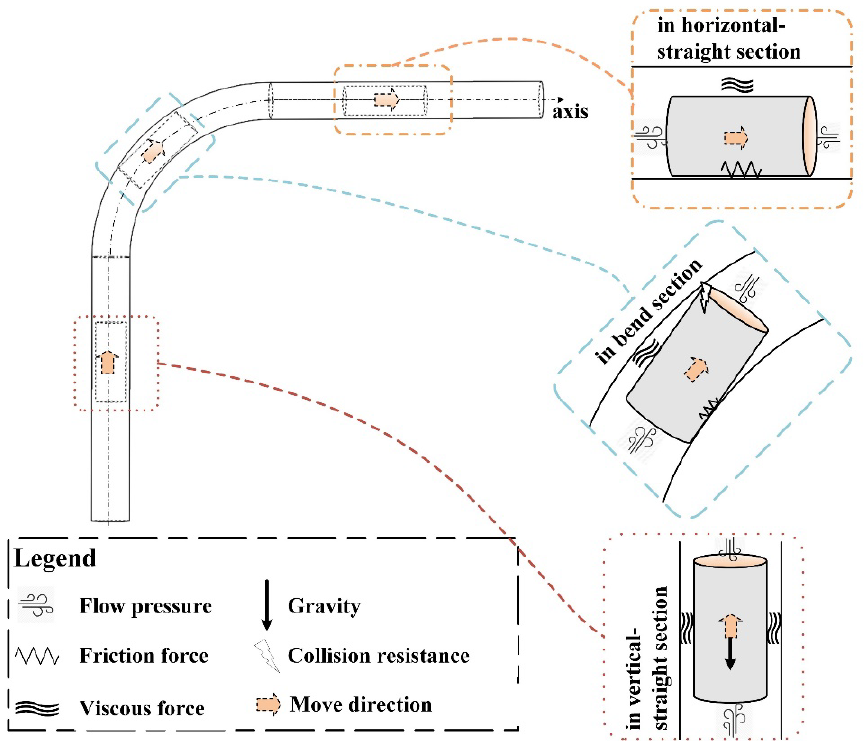
Figure 1. Schematic diagram of force analysis for capsules moving in PCP.